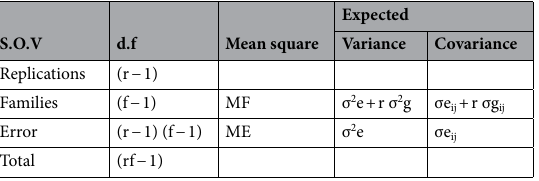
Table 9. Analysis of variance and covariance on plot mean basis in F 3 and F 4